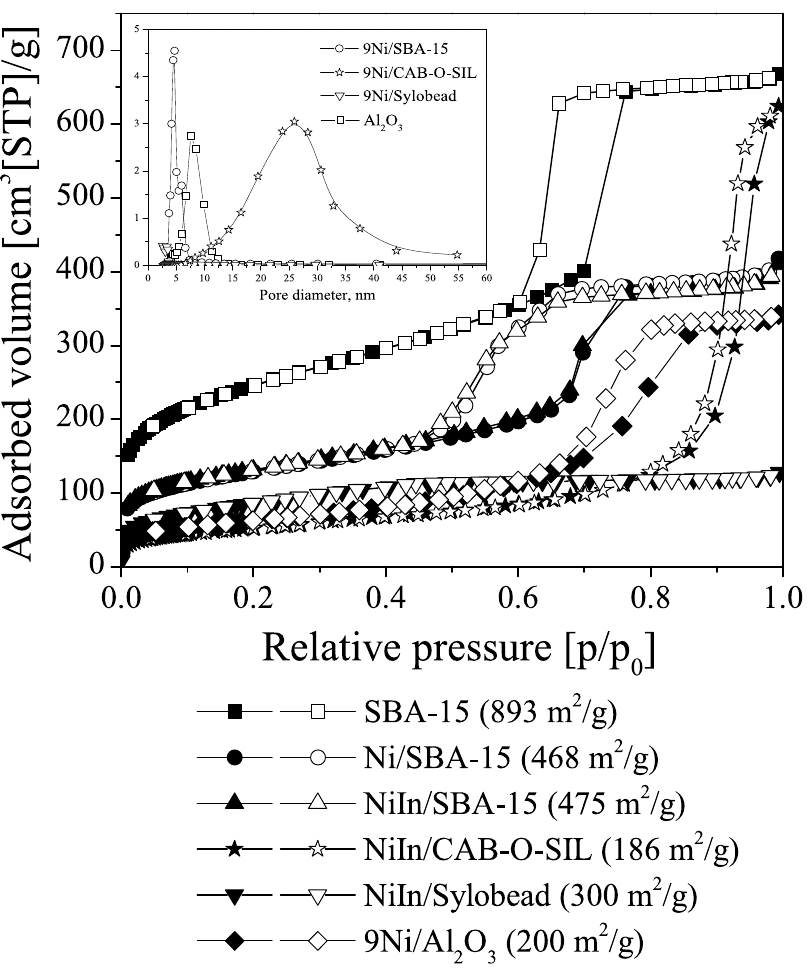
Figure 7 : Adsorption and desorption isotherms of nitrogen at -196°C of unloaded, Ni loaded SBA-15, alumina and Ni+In loaded SBA-15, Sylobead and